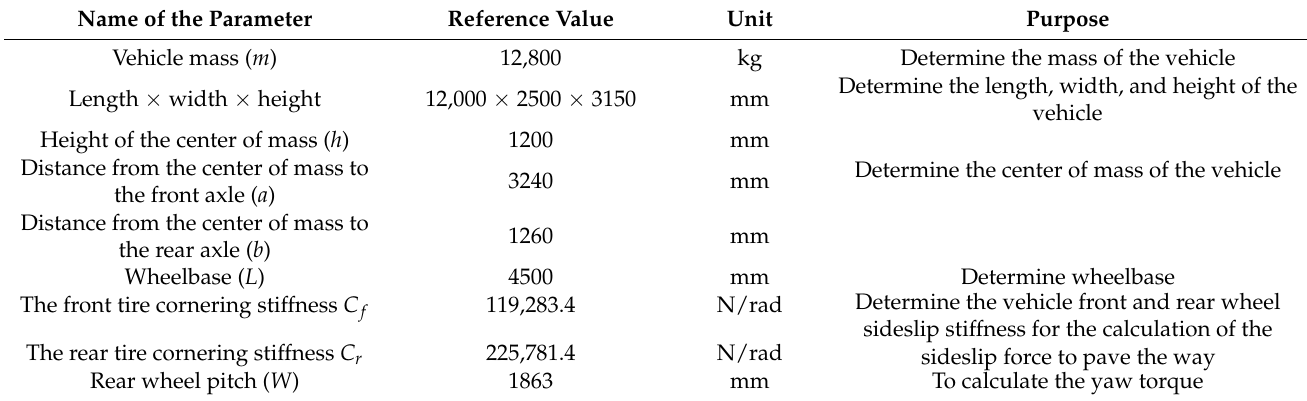
Table 1. Reference values for some parameters of an electric bus.